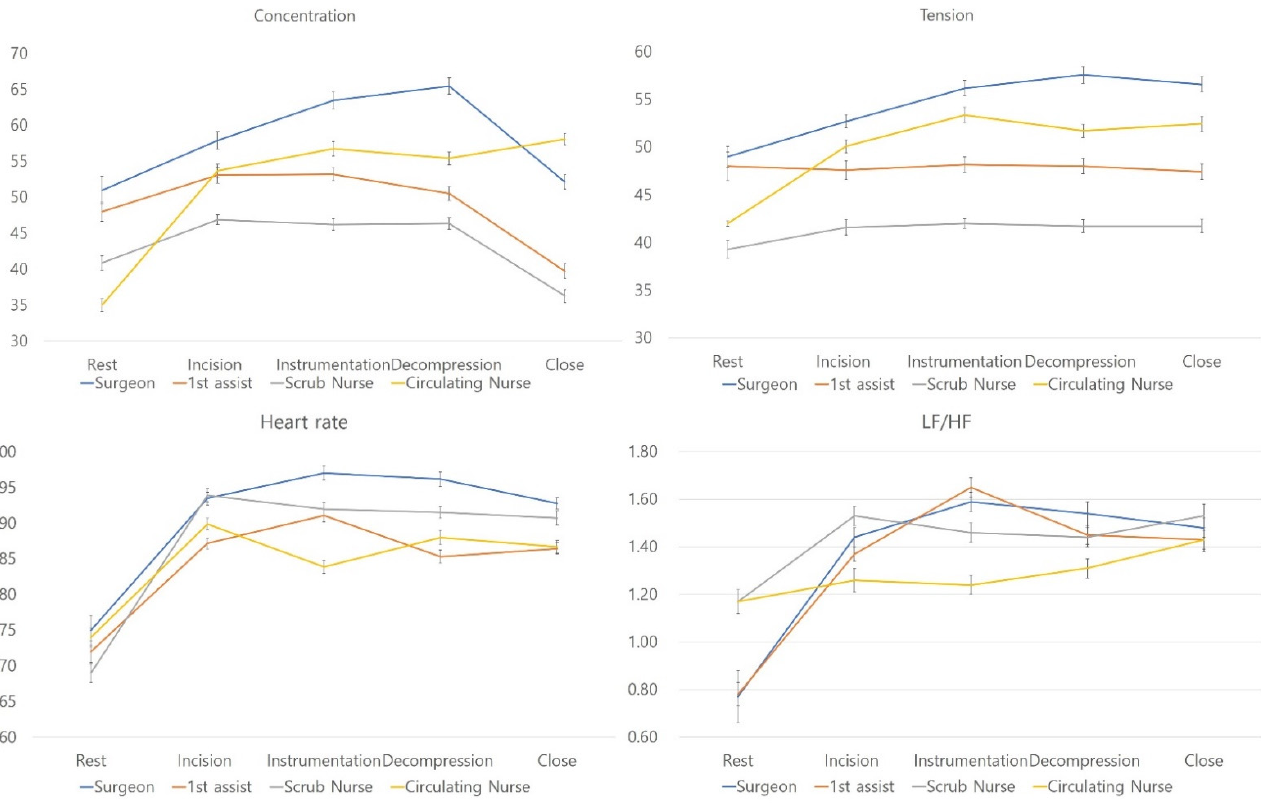
Figure 1. Stress-related parameters during surgery.